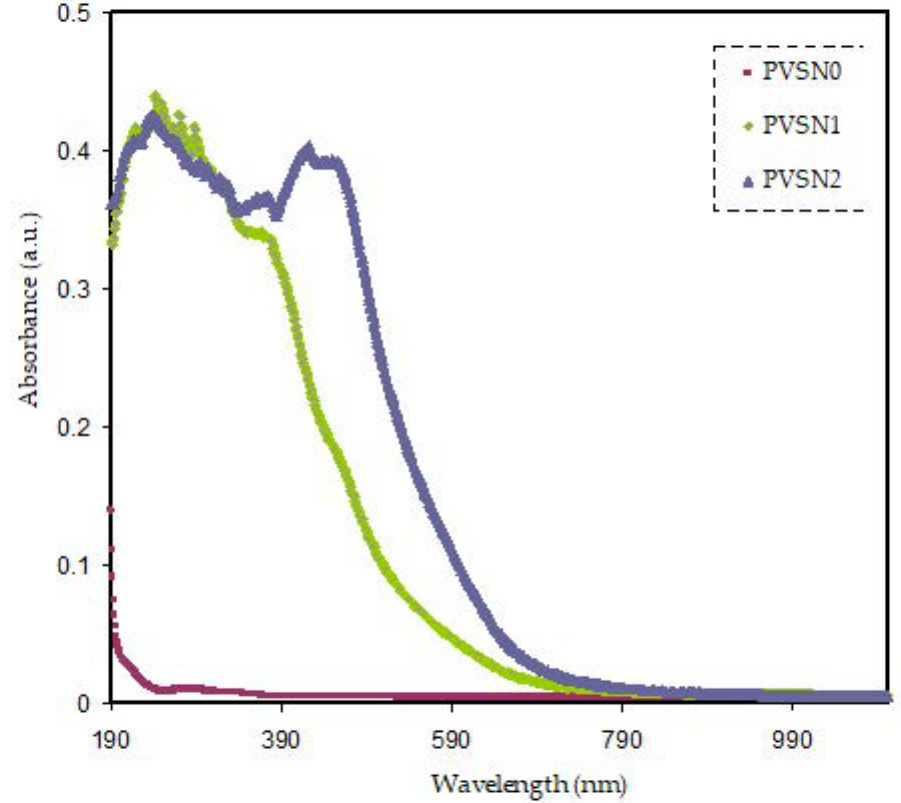
Figure 6. Absorption spectra for pure PVA and loaded